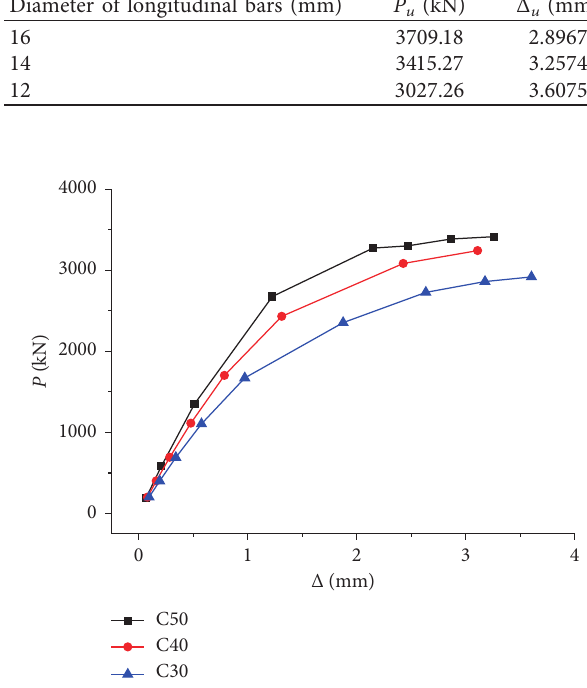
Figure 14: Influence of concrete strength on specimen performance. Table 4: Influence of concrete strength on ultimate axial bearing capacity and displacement of the specimen.